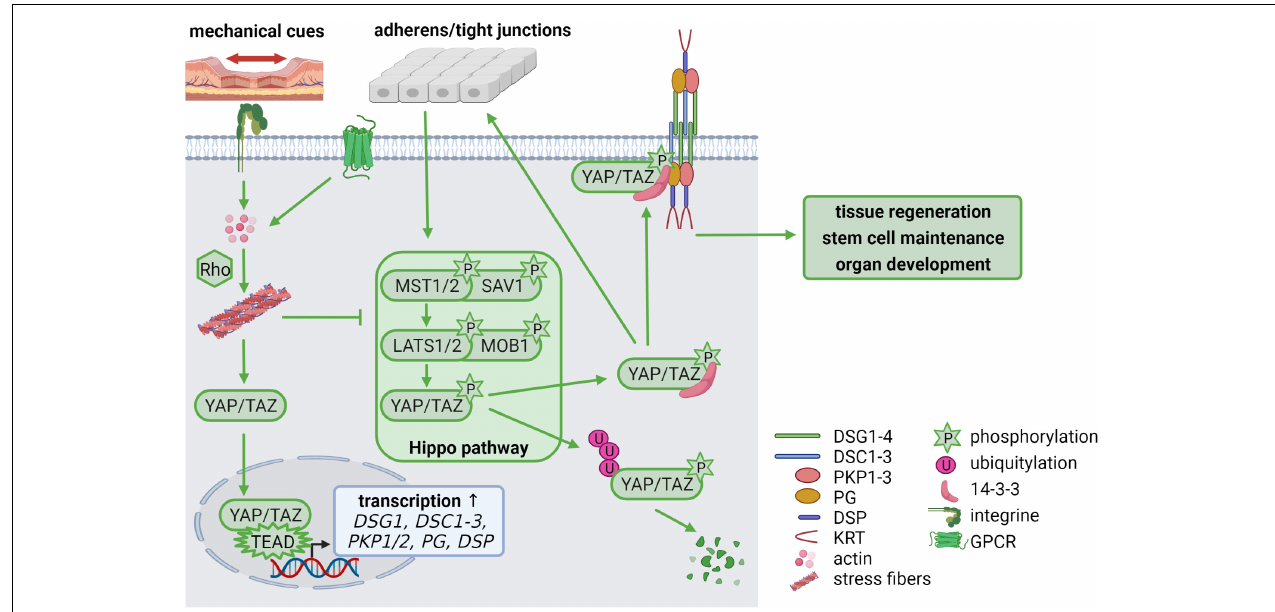
FIGURE 4 | Mechanical cues regulate cellular homeostasis via Hippo signaling (created with biorender.com) . Cell-cell contacts control the activation of the Hippo signaling cascade via phosphorylation of MST(Hippo)/SAV and LATS/MOB. The phosphorylated downstream targets YAP/TAZ are degraded via ubiquitylation or stabilized in the cytoplasm by 14-3-3-binding, which facilitates YAP/TAZ association with cell-cell contacts including adherens junctions, tight junctions and desmosomes. Mechanical tension activates RhoA via integrin signaling which promotes stress fiber formation. G protein-coupled receptors (GPCRs) can also activate Rho to promote stress fiber assembly. This inhibits LATS leaving YAP/TAZ in an unphosphorylated state. Unphosphorylated YAP/TAZ translocates from the cytoplasm to the nucleus, where it forms a complex with TEAD transcription factors, resulting in increased transcription of TEAD target genes including DSG1 , DSC1-3 , PKP1/2 , PG , and DSP . Thus, mechanical cues control desmosomal gene expression via the Hippo cascade but, in a feedback mechanism, desmosomes modulate mechanosignaling by capturing YAP/TAZ at the plasma membrane, to maintain the balance between proliferation, differentiation, migration, and invasion.